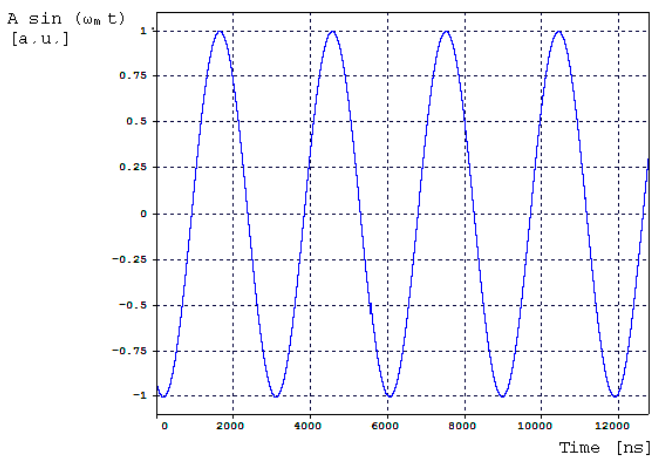
Figure 10. Bias-sinusoidal voltage signal provided by the AC signal generator and applied to Phase-Modulator (PZT, scope 1 in Figure 9). Sinusoidal curve parameters are: f m “ A “ 1 r a . u . s .